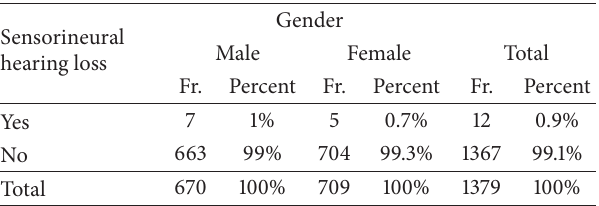
Table 5: Frequency distribution of sensorineural hearing loss based on